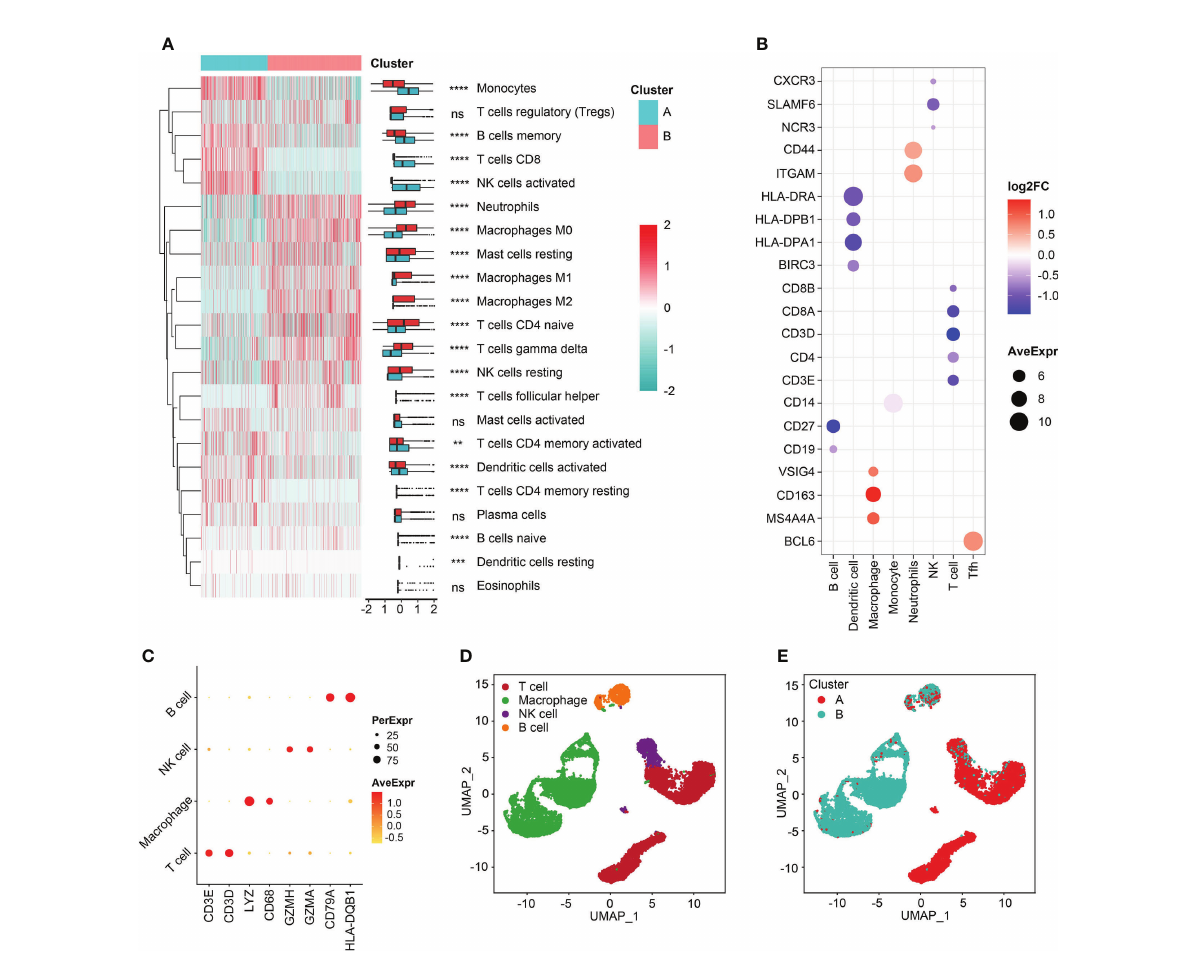
FIGURE 5 Immune reprogramming analysis. (A) Complex heatmap of immune cell fractions between cluster A and cluster B. (B) Scatter plot of log2FC values of immune cell markers. Color red represented the genes were relatively overexpressed in cluster B and color blue represented markers were comparatively upregulated in cluster A. (C) Scatter plot of markers expressed in single cell RNA-sequencing samples. (D) Cell annotation analysis identi fi ed four types of cells. (E) The distribution offour types of cells between the two clusters. **p < 0.01; ***p < 0.001; ****p < 0.0001; ns, not signi fi